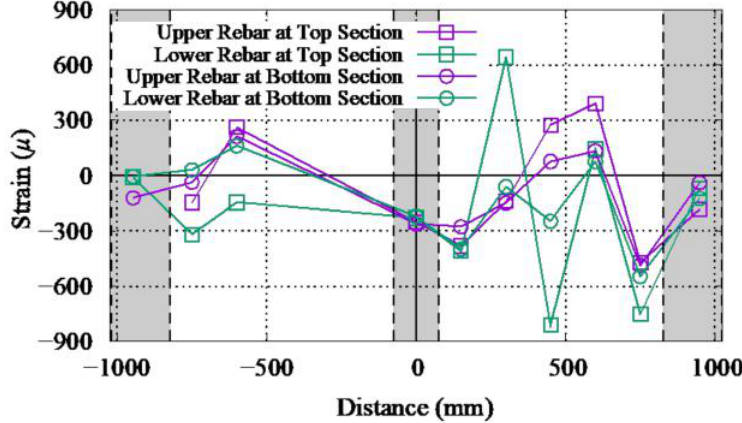
Figure A3. Cross-sectional distribution of the shrinkage strain at both